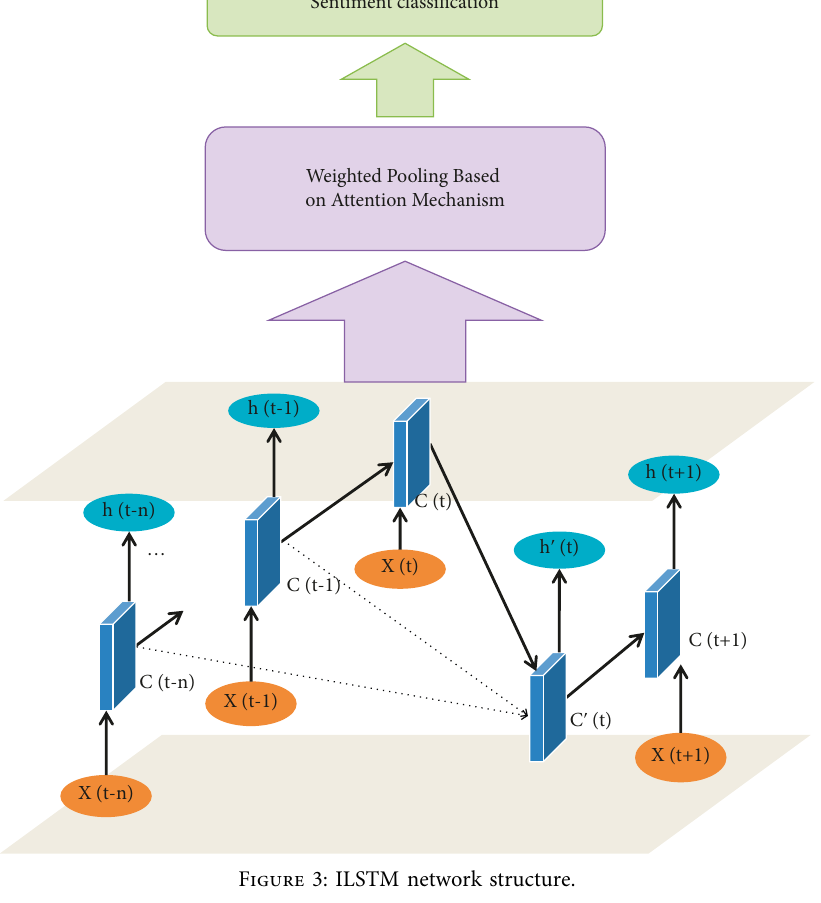
Figure 3: ILSTM network structure.